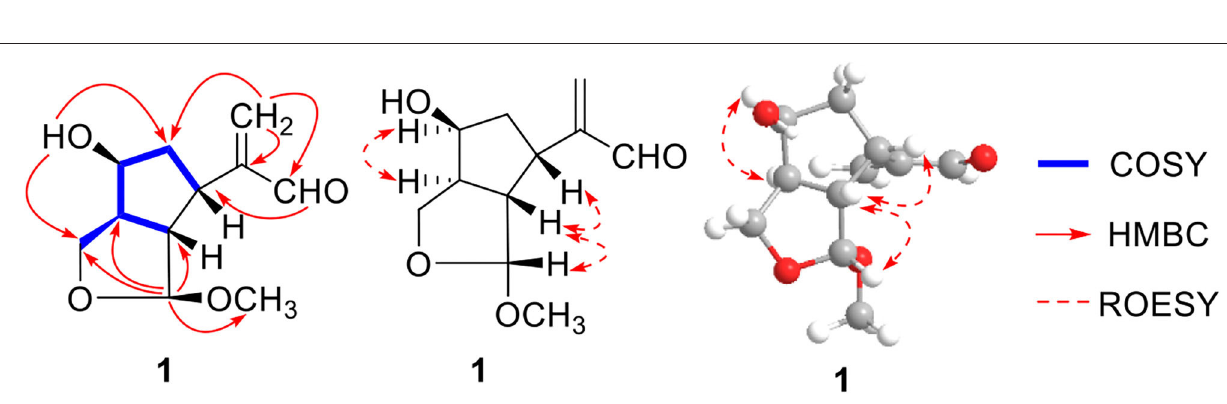
agreed with the experimental ECD spectra ( Figure 4